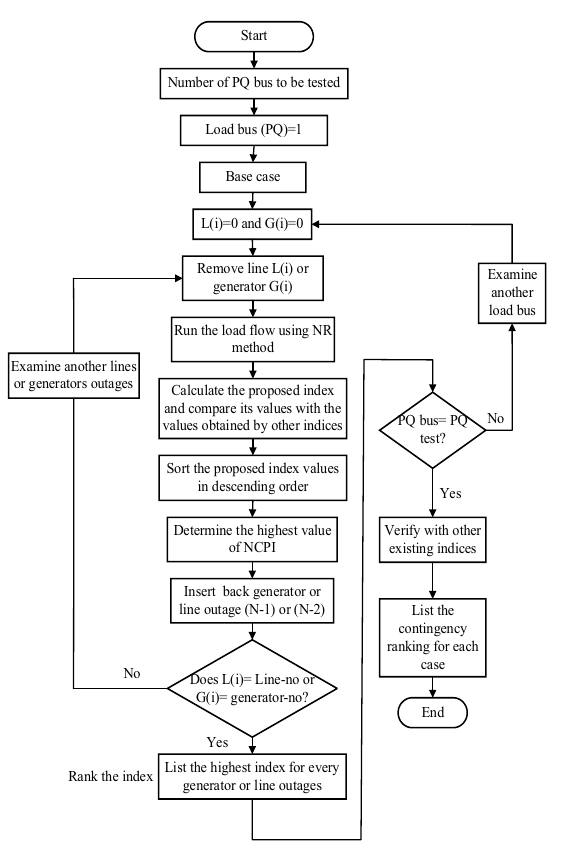
Fig. 3 Flow chart for contingency ranking and